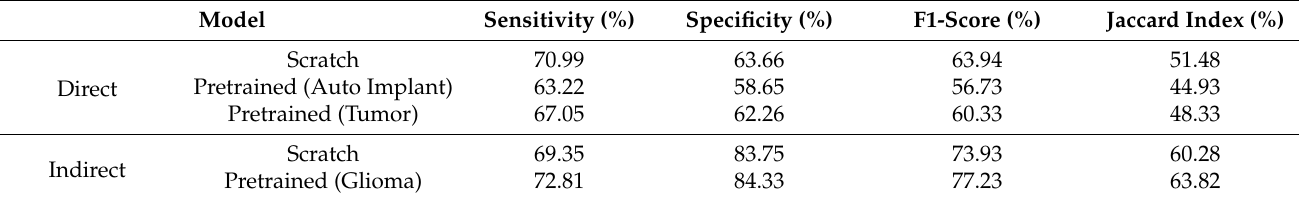
Table 2. Segmentation performance for external